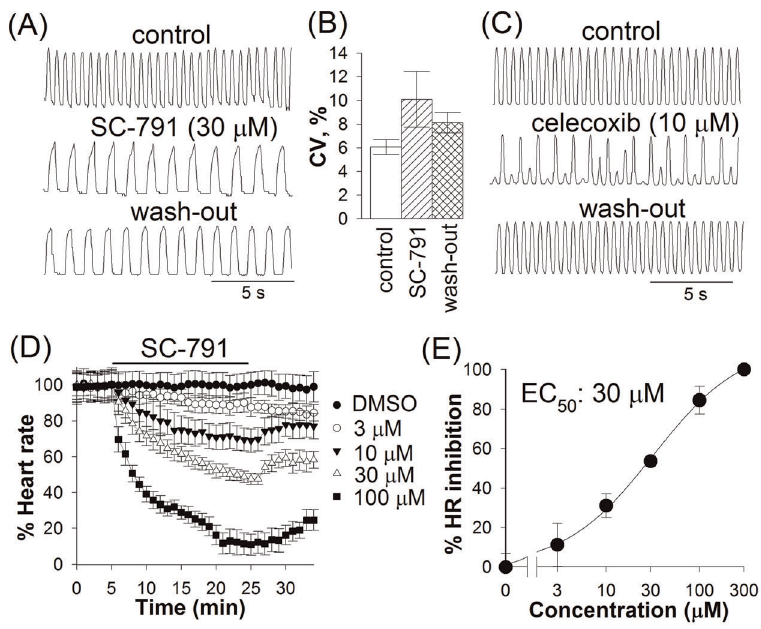
Figure 3. Effects of SC-791 on heartbeat. Traces represent the relative displacement of an edge of the larval heart in the experiments with SC- 791 ( A ) or celecoxib ( C ); heartbeat was video recorded immediately before drug application, at 18–20 min after wash-in of 30 m M SC-791 or at 8– 10 min after application of 10 m M celecoxib, and at 8–10 min after washing the drug out; ( B ) depicts heartbeat irregularity in the presence of 30 m M SC-791; the coefficient of variation (CV) was calculated as described previously [8]; the number of experiments was 8. ( D ) Average heart rate is shown for 6–10 larvae before drug application, after rapid wash-in of 3 m M, 10 m M, 30 m M, or 100 m M SC-791 (horizontal bar), and after the wash-out; treatment with 0.5% Me 2 SO, the maximum concentration of Me 2 SO used with SC-791, did not change the heart rate significantly. ( E ) A dose-response curve for the effect of SC-791 on heart rate is shown.